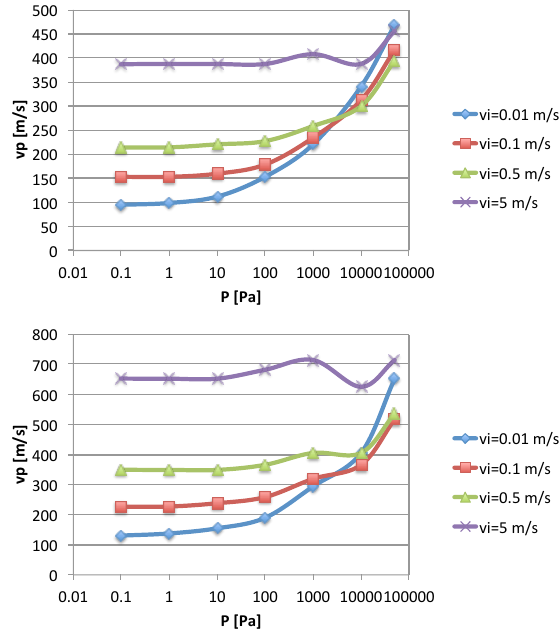
Figure 2. Wave speed versus overburden pressure at dif- ferent impact speeds (logarithmic scale) for cohesionless grains. Top: RCP, bottom: